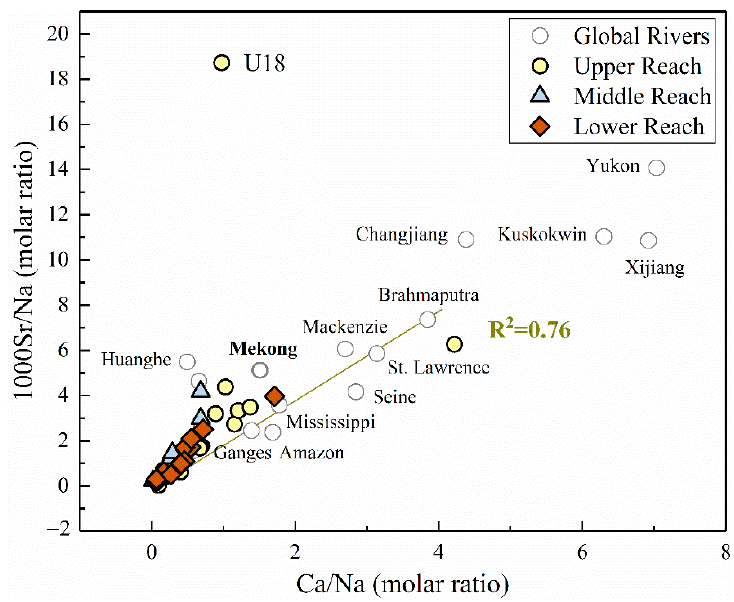
Figure 6. The molar ratio of 1000Sr/Na versus Ca/Na in the MRB and other large rivers around the world (gray hollow dots). Data of major world rivers were derived from [1] .